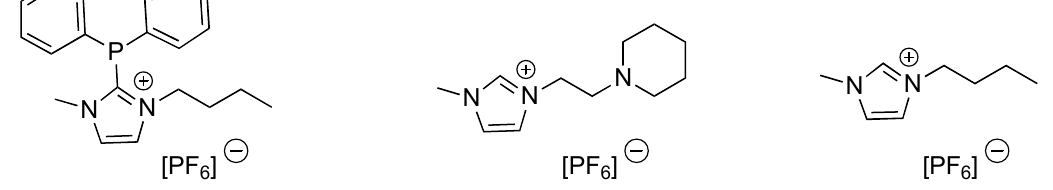
Figure 12. Mixture of monofunctionalized